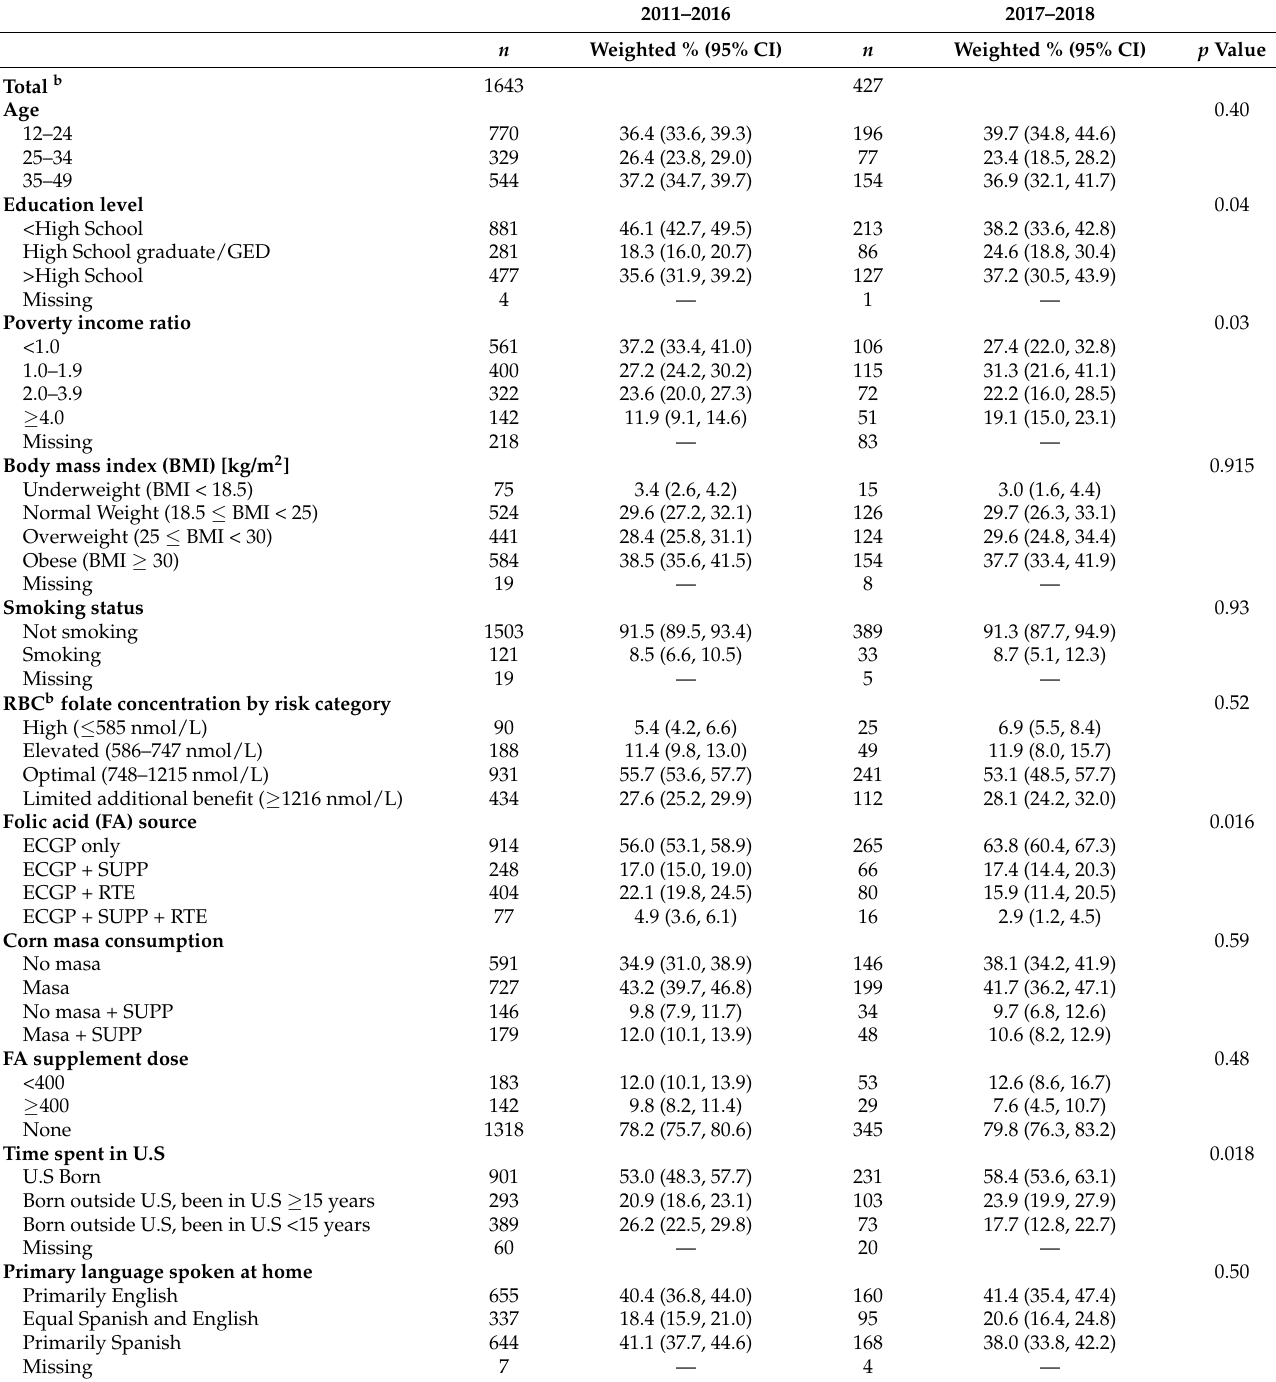
Table 1. Demographic and behavioral characteristics of U.S. Hispanic women of reproductive age (12–49 years), National Health and Nutrition Examination Survey (NHANES) a 2011–2018, stratified by pre- and post-implementation of corn masa